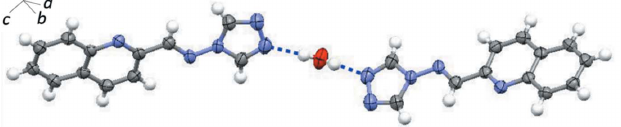
Figure 2 A partial packing diagram of the title compound, showing two Schiff base molecules linked by two identical intermolecular O—H (cid:2)(cid:2)(cid:2) N hydrogen bonds.